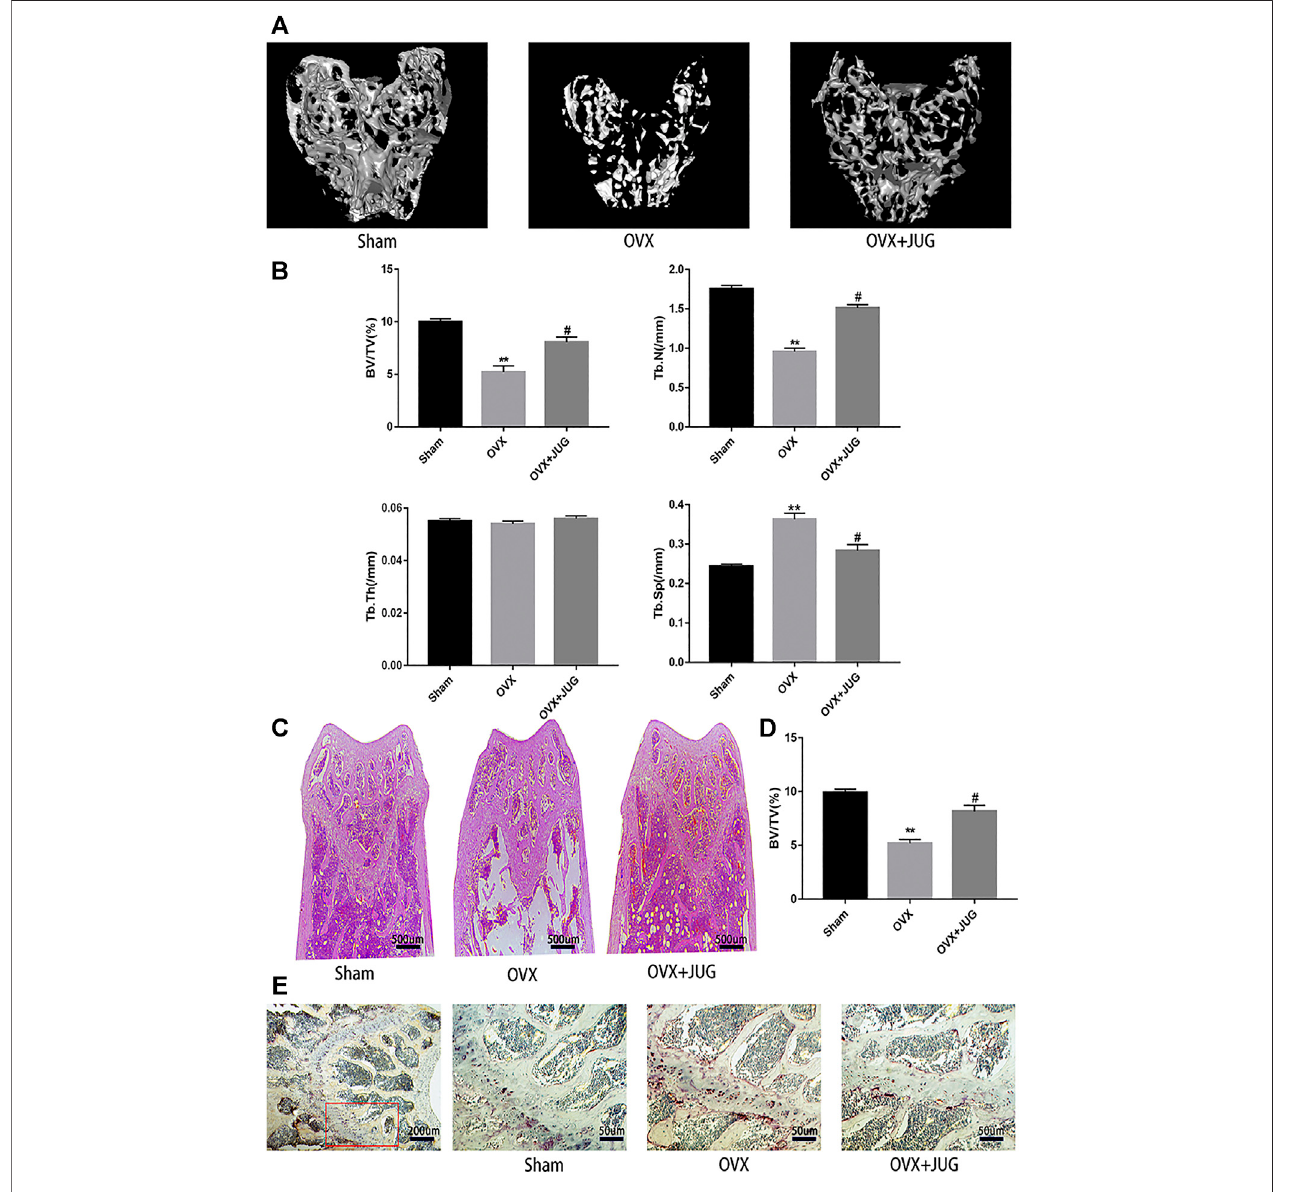
FIGURE 7 | JUG ameliorates ovariectomy-induced bone loss in vivo . (A) Micro CT analysis of the distal femur from sham, OVX, and OVX + JUG group (B) Bone volumepertissuevolume(BV/TV),trabecularnumber(Tb.N),trabecularthickness(Tb.Th)andtrabecularseparation(Tb.Sp)wereanalyzedwithmicro-CTSkyscanCTAn software. (C – D) HE staining of distal femoral and quanti fi cation of BV/TV (E) TRAP-stained histologic distal femur from sham, OVX and OVX + JUG group.